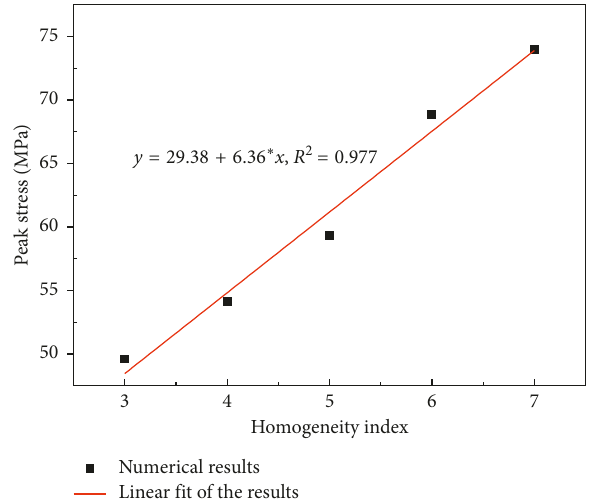
Figure 6: The linear fit of numerical results of UCT with different homogeneity